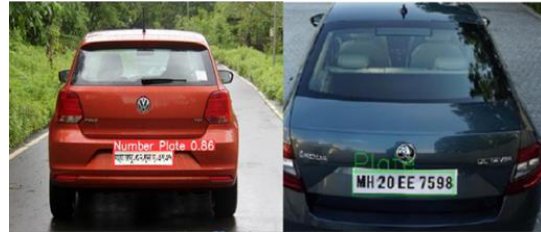
Fig. 4. Image after the detection of license plate using YOLOv5 Model